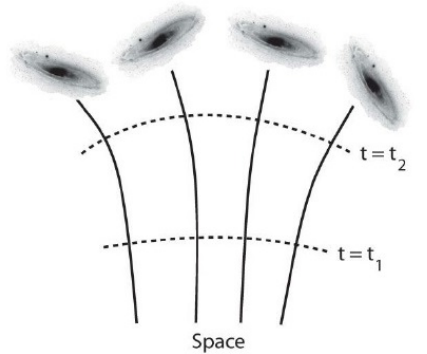
Figure 9. Illustration of the Weyl